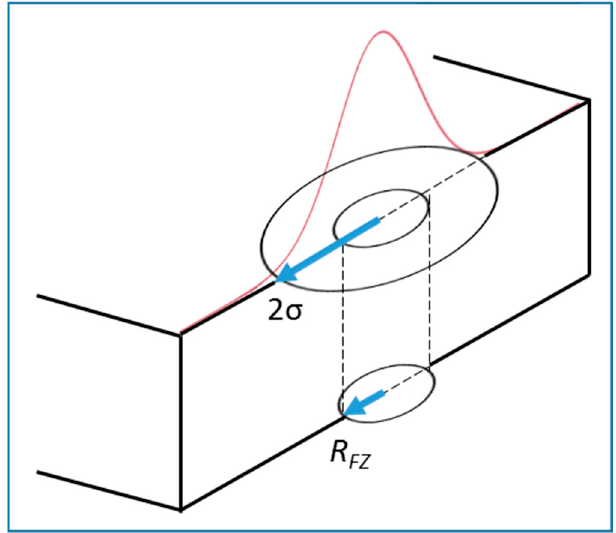
Figure 5. Total heat flux in 3D heat distribution.